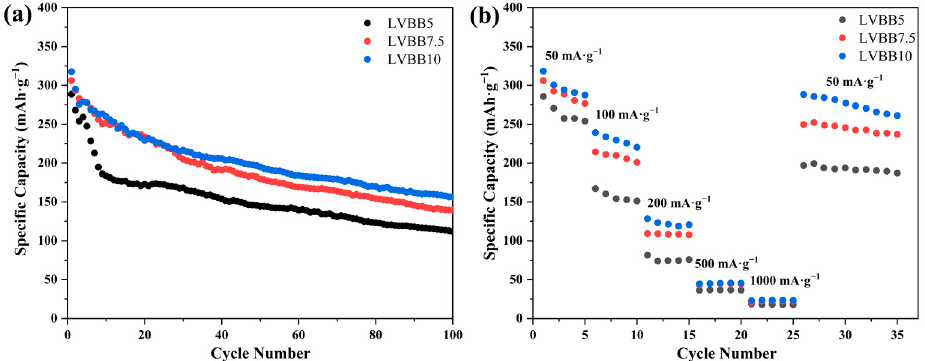
Figure 4. ( a ) Cycling data showing the initial 100 cycles (at 50 mA · g − 1 , in the voltage range of 1.5–4.2 V) and ( b ) rate capability tests (at different rates from 50 to 1000 mA · g − 1 ) of all three samples LVBB5, LVBB7.5 and LVBB10.